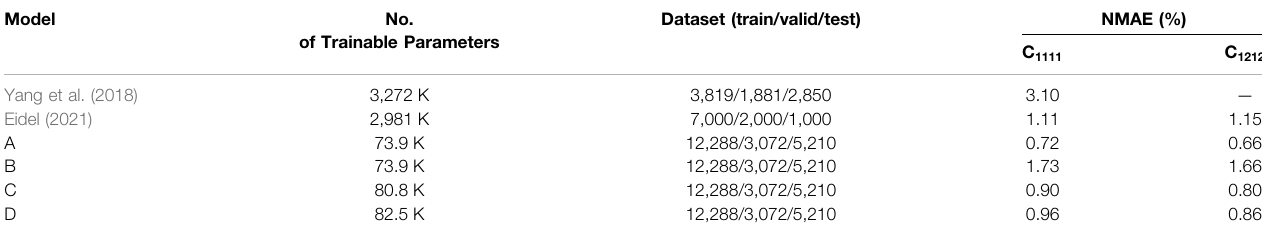
TABLE 2 | Summary of the performance of selected CNN models produced in this work and their comparison with benchmarks form literature.